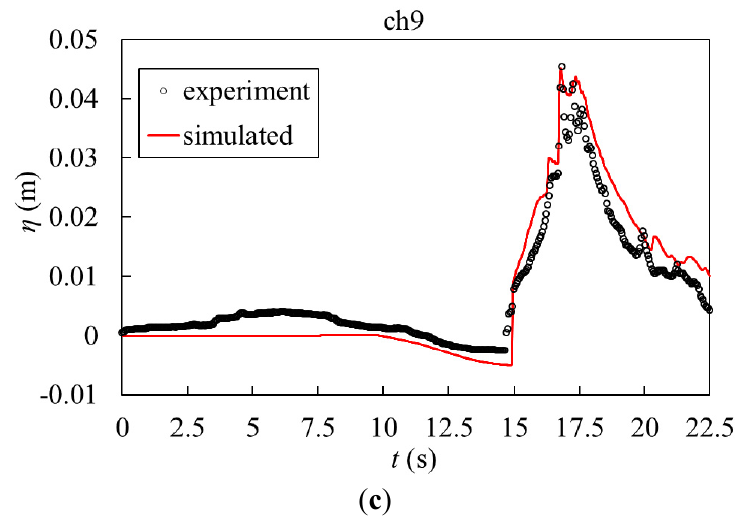
Figure 5. Comparison between computed and measured water elevations at different gauges ( η represents water elevation). Numerical results are plotted in red lines and experimental measurements are plotted in black circles. ( a – c ) represent the water elevation varying with time at gauges ch5, ch7, and ch9, respectively.